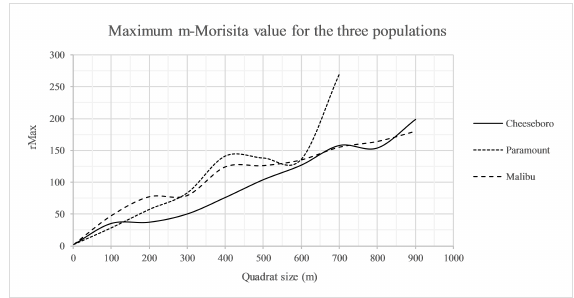
Figure 7. Curves of rMax variation showing how clustering is a function of relative quadrat size extent for the three populations. A positive slope indicates clustering at those quadrat sizes, and a peak indicates a quadrat size where clustering ceases or a limit to cluster size. Falling slopes indicate dispersion, and level or near zero slope indicates a random spatial